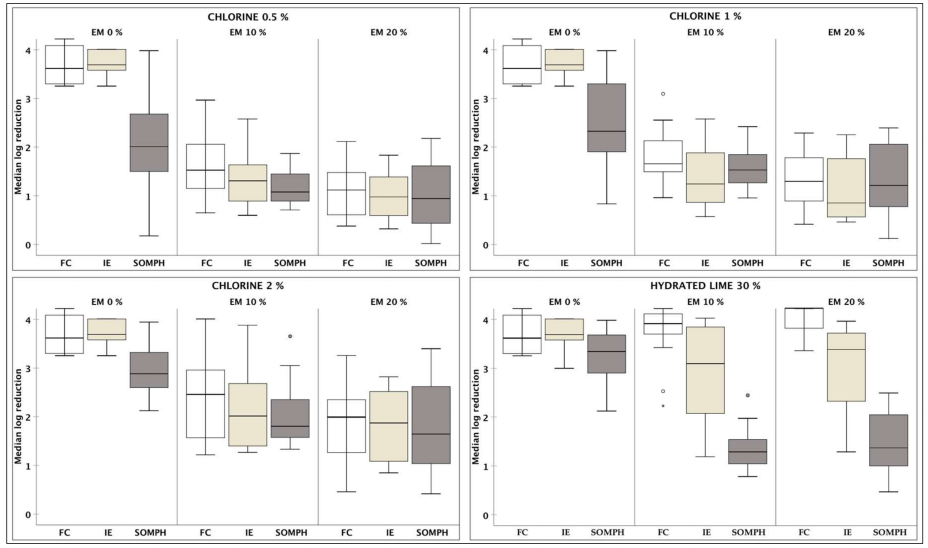
Figure 3. Box-plots displaying median log reduction of all microorganism (faecal coliforms (FC), intestinal enterococci (IE) and somatic coliphages (SOMPH)) levels, with respect to treatment approach and each excreta matrix